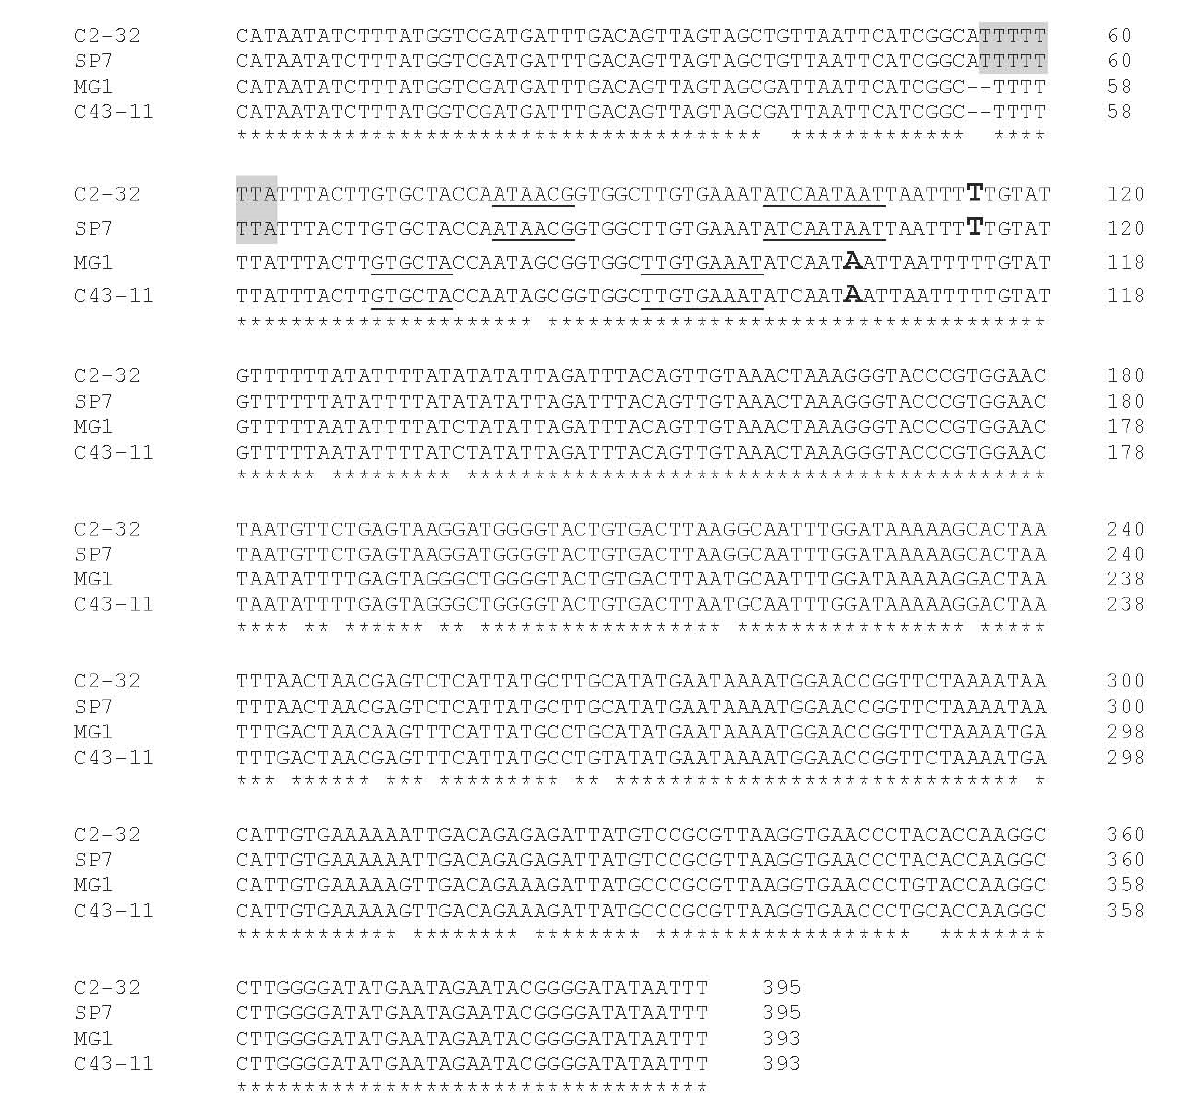
Figure 4. Alignment of the promoter regions of C2-32, C43-11, SP7, and MG1 strains with the in silico predicted − 35 and − 10 motifs ( underlined text ), transcriptional start sites ( bold letters ), and lexA ( light gray ) DNA-binding motif indicated.